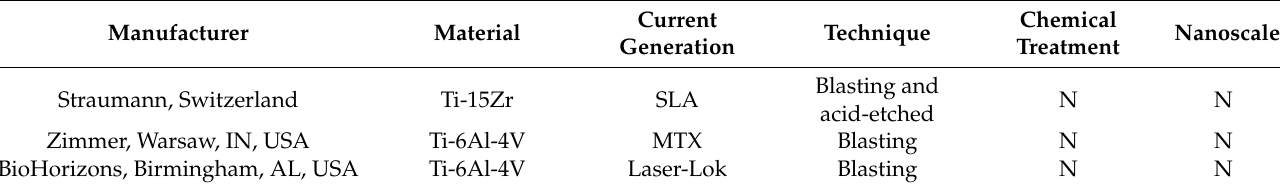
Table 1. Comparison between different implant systems.